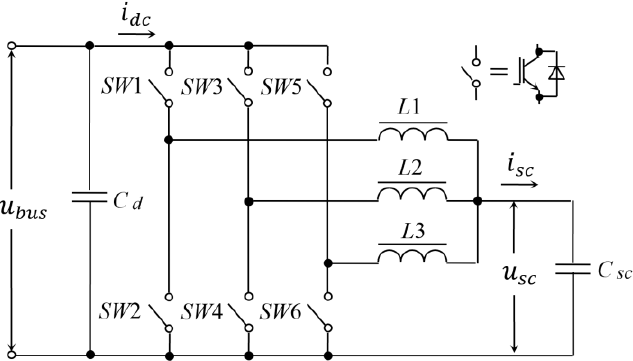
Figure 16. Topology of a three-phase DC/DC interleaved converter.